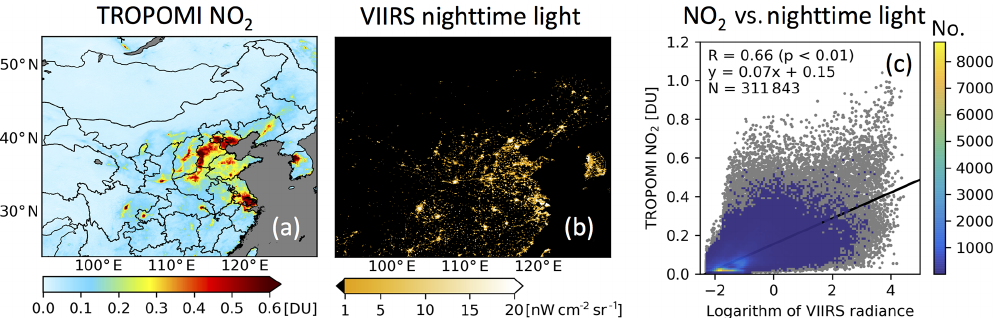
Figure 2. Panels (a) and (b) show TROPOMI NO 2 VCD and VIIRS nighttime light radiance at the 0 . 05 ◦ × 0 . 05 ◦ resolution in April 2018. Panel (c) shows a scatter plot of TROPOMI NO 2 versus the logarithm of VIIRS nighttime light radiance (grid cells with VIIRS nighttime light radiance less than 0.1nWcm − 2 sr − 1 are